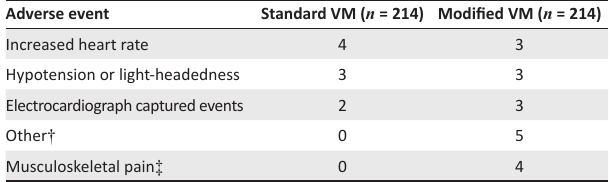
TABLE 2: The Revert trial – Frequency of adverse events. Adverse event